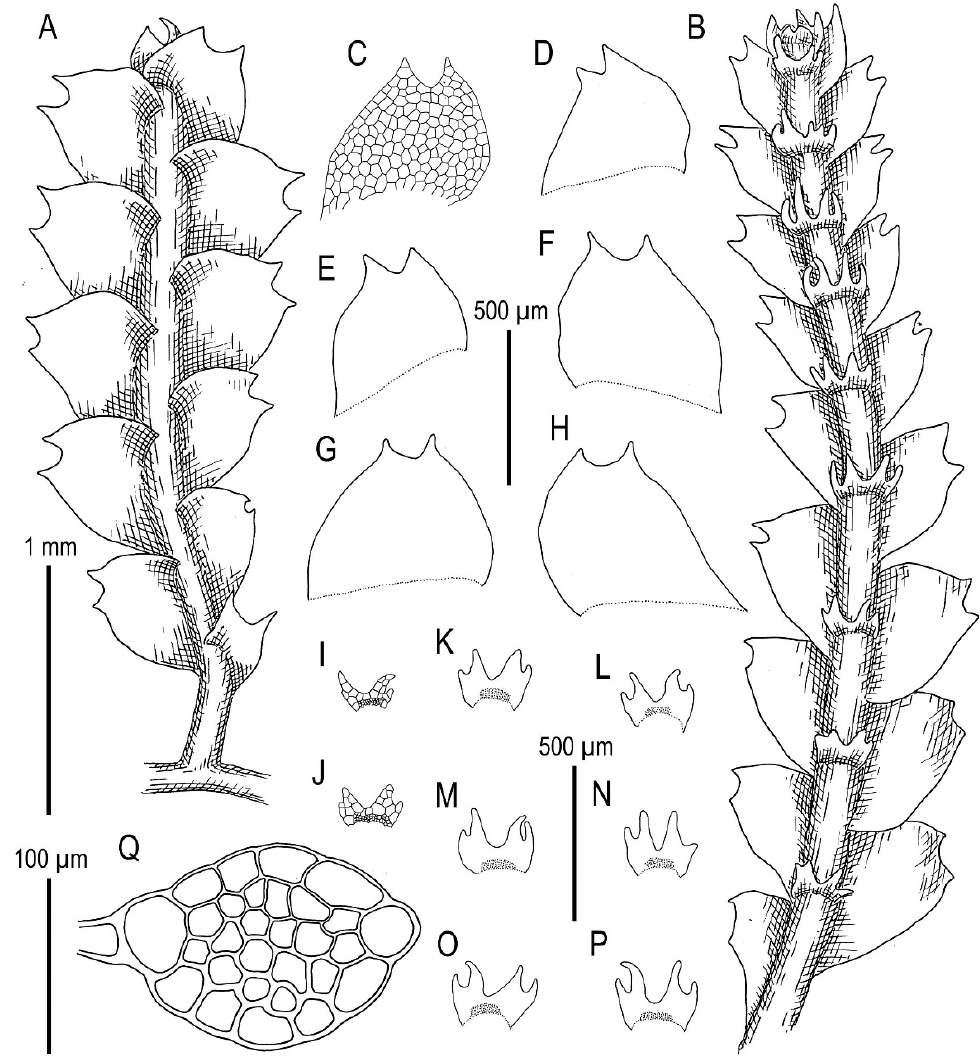
Figure 12. Asperifolia indosinica Bakalin et Troizk., sp. nov. : ( A ) Plant habit, fragment, dorsal view; ( B ) Plant habit, fragment, ventral view; ( C – H ) Leaves; ( I – P ) Underleaves; ( Q ) Stem cross section. All from V-1-112-16 (VBGI).